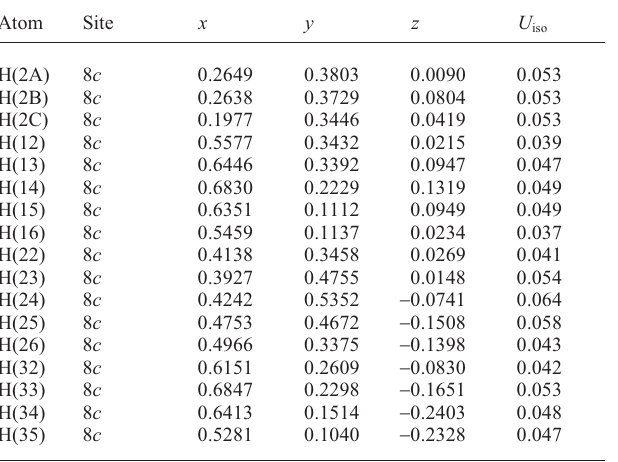
ligand. In the crystal, two C–H (cid:7)(cid:7)(cid:7) Cl contacts whose range below the sum of van-der-Waals radii of the atoms participating in them can be observed [9]. Both are apparent in between one of the hy- drogen atoms in ortho position to the phosphorus atom the per- taining phenyl group is bonded to as donor and one of the monodentate chlorido ligands as acceptor giving rise to the for- mation of centrosymmetric dimers while the second C–H (cid:7)(cid:7)(cid:7) Cl contact – that is also supported by a hydrogen atom in ortho posi- tion to the phosphorus atom it is bonded to and also applies a monodentate chlorido ligand as acceptor – connects the mole- cules to chains. It is pertinent to note that both chlorido ligands that participate in these contacts as acceptors are bonded to the same rhenium atom. In total, the molecules are connected to planes perpendicular to the crystallographic a axis. In terms of graph-set analysis [10, 11], these contacts necessitate a C 1 1 (7) R 2 2 (12) descriptor on the unary level. Furthermore, one C–H (cid:7)(cid:7)(cid:7) (cid:7) contact is apparent in the crystal structure. The shortest ntercentroid distance between two centers of gravity was mea- sured at 4.006(3) Å and is observed between two phenyl groups bonded to the two different types of phosphorus atoms in neigh- bouring molecules.